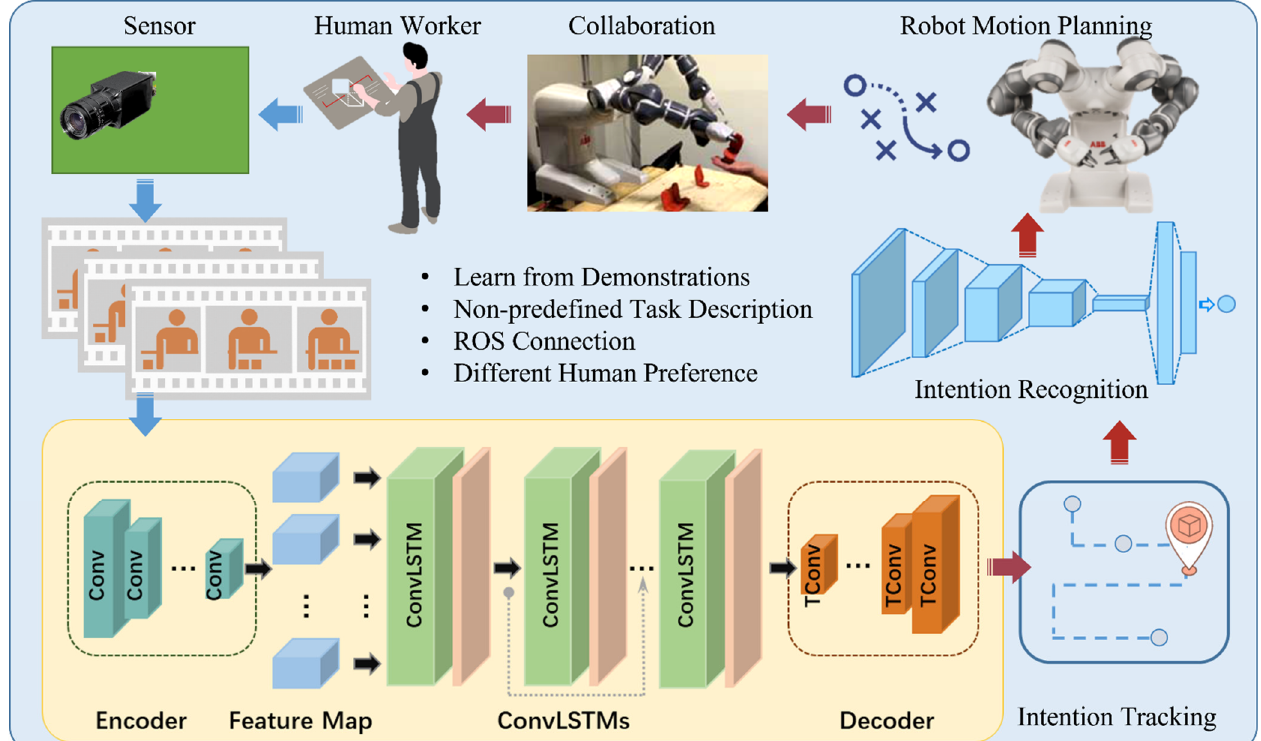
Figure 1. Prediction-based human-robot collaboration framework.